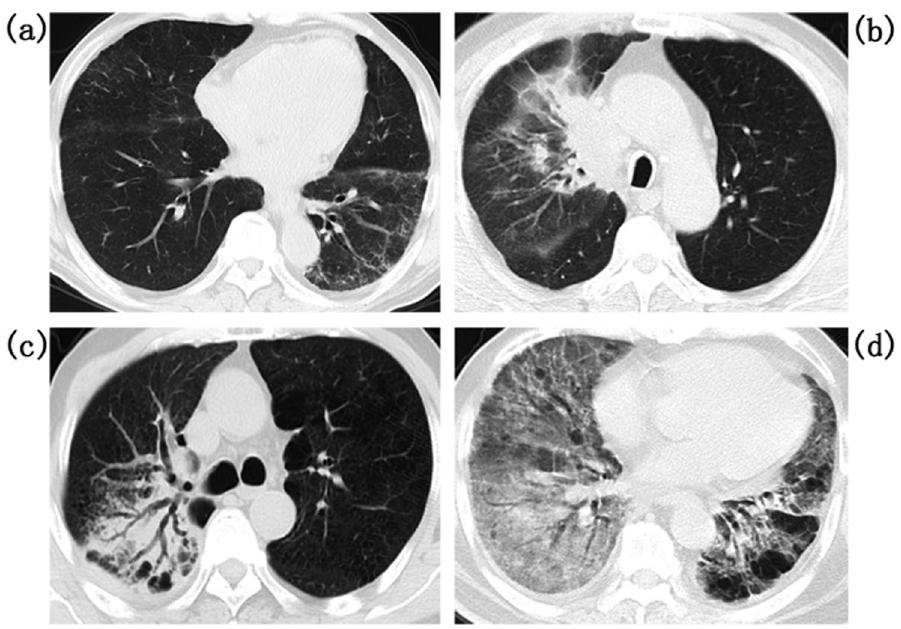
Figure 2. Radiation pneumonitis (RP) in computed tomographic (CT) images: ( a ) Grade 1, ( b ) Grade 2, ( c ) Grade 3, and ( d ) Grades